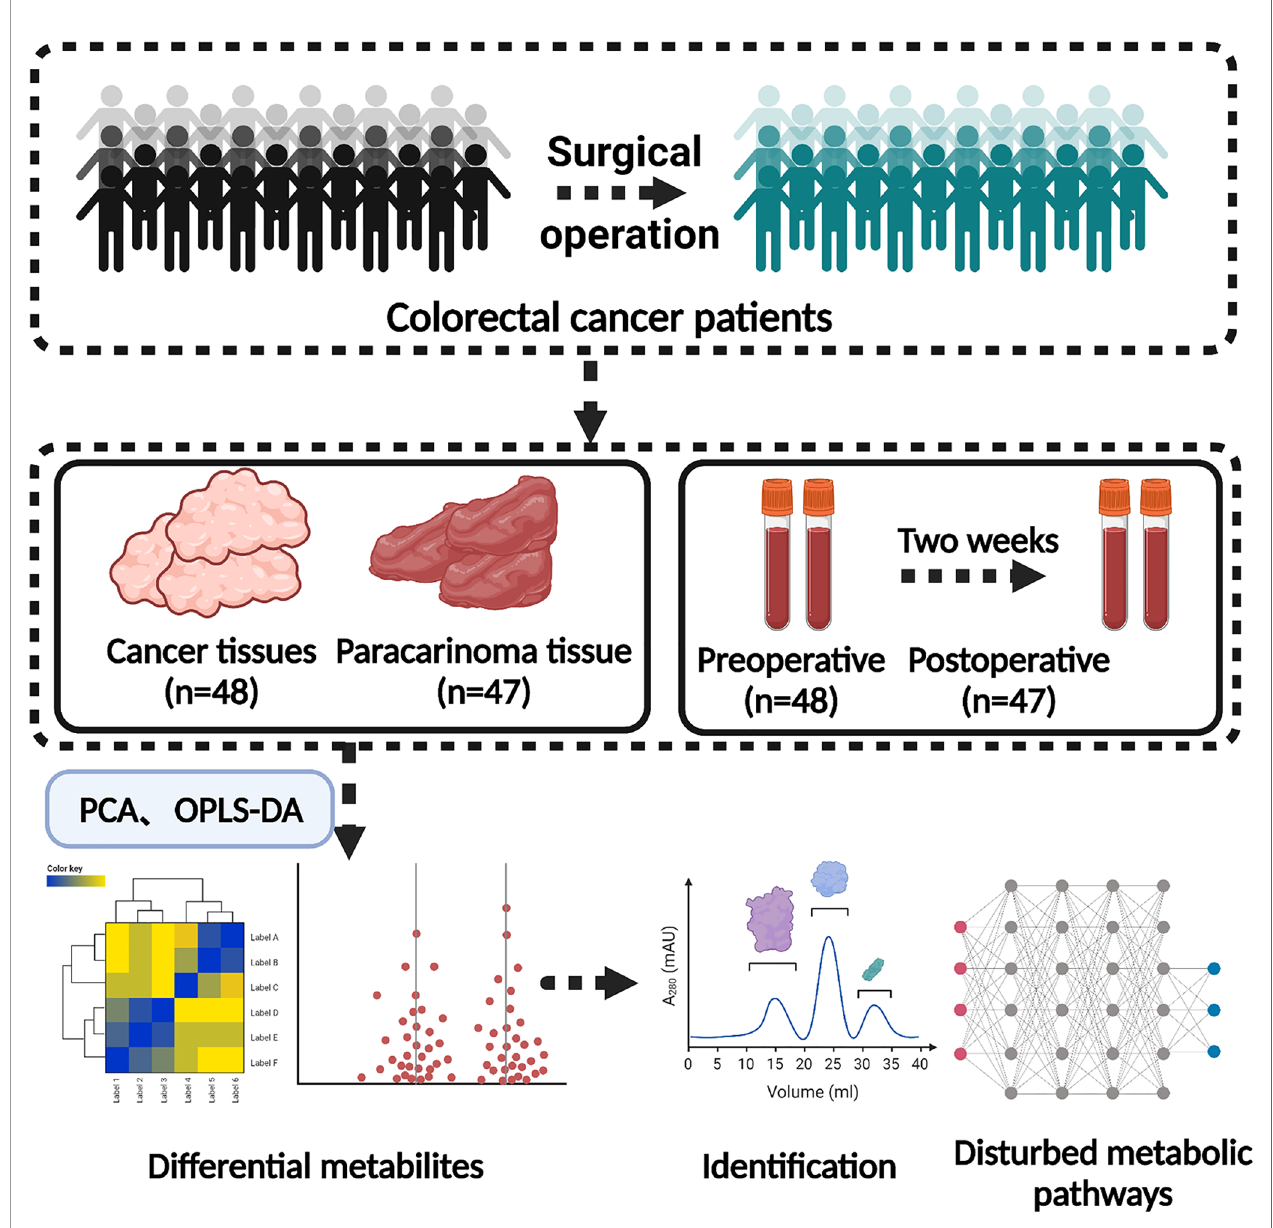
FIGURE 1 | The schematic diagram of the experimental